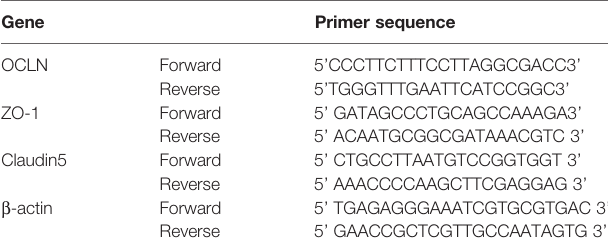
TABLE 1 | Primer sequences for